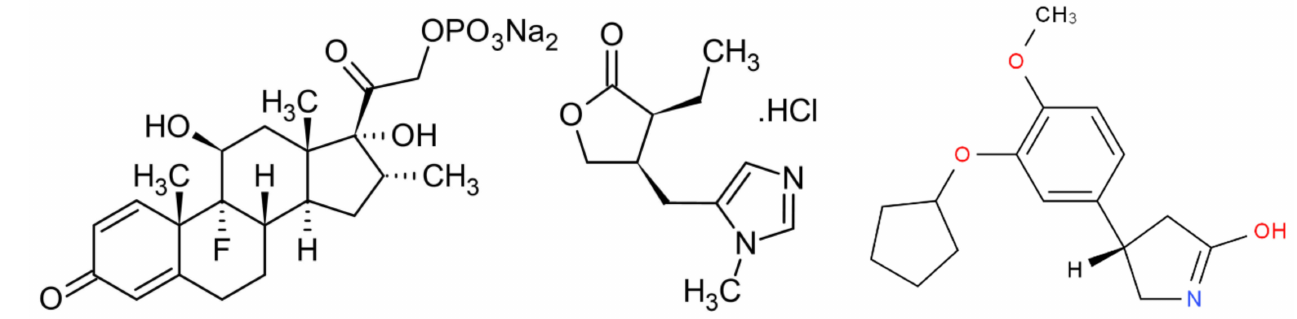
Figure 13. Structure of dexamethasone phosphate ( left ), pilocarpine hydrochloride ( middle ) and bevacizumab ( right